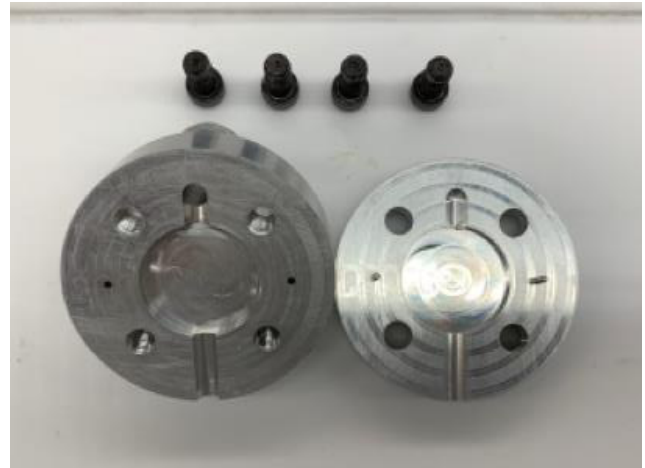
Figure 1. Custom split-die injection mold with a cavity size of 25.4 × 6.35 mm used to form samples for compression and hardness testing.